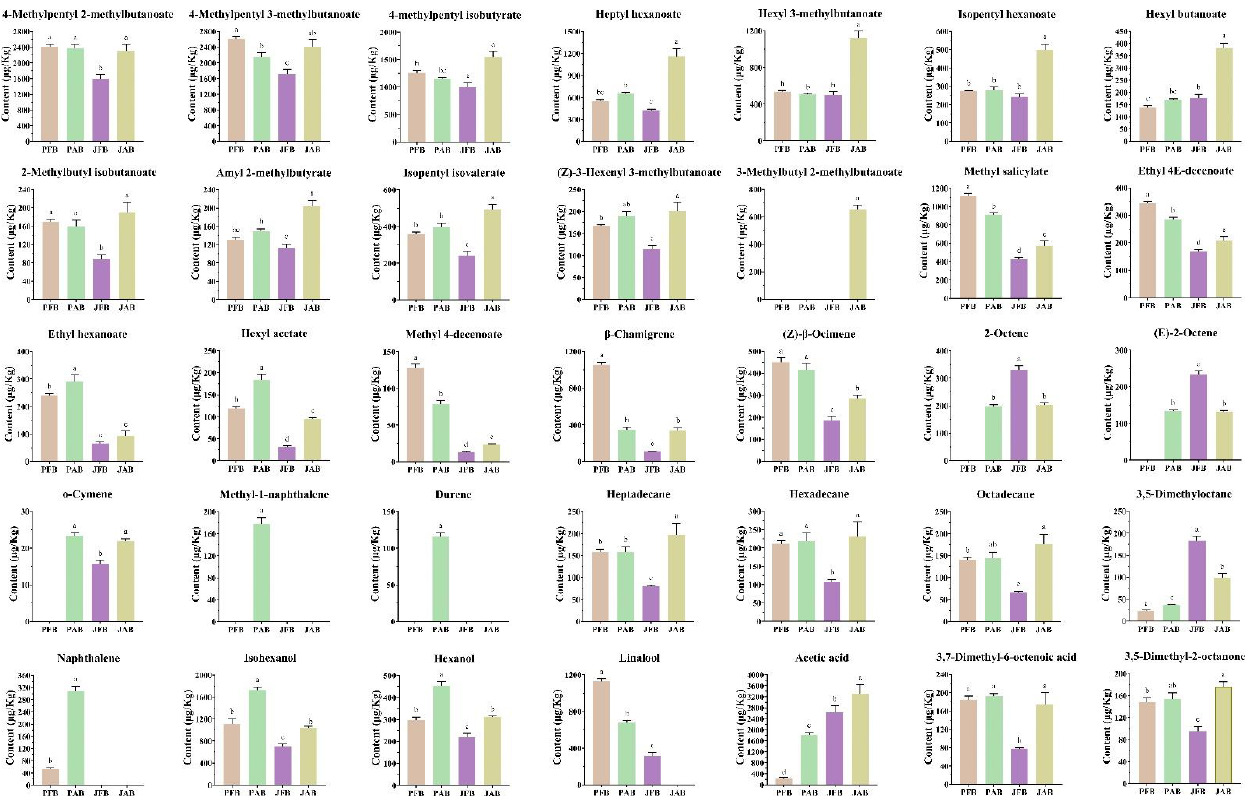
Figure 6. Discriminative volatile compounds content in pickled chili pepper processed by PFB, PAB, JFB, and JAB. Significant differences ( n = 3, p < 0.05) were indicated with different letters.